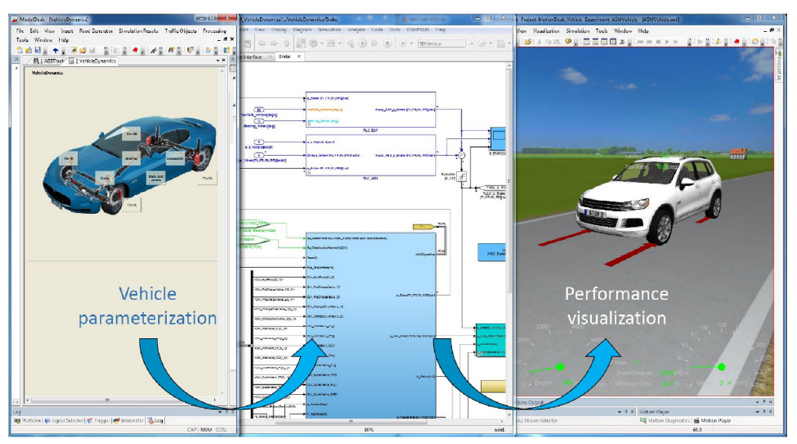
Figure 8. Simulation software interface by the dSPACE ® GmbH.